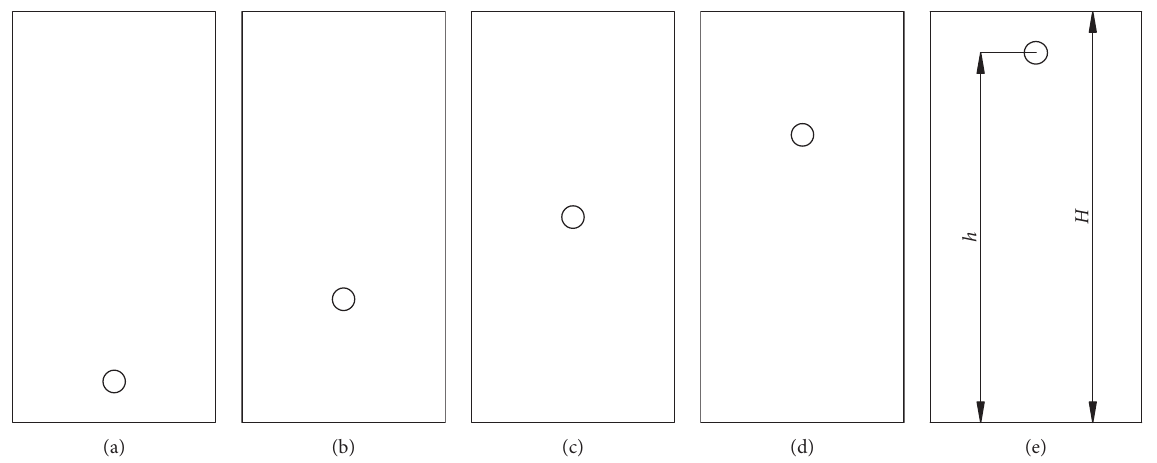
Figure 4: Numerical test samples with different borehole height ratio. The R of (a), (b), (c), (d), and (e) are 0.1, 0.3, 0.5, 0.7, and 0.9, respectively.